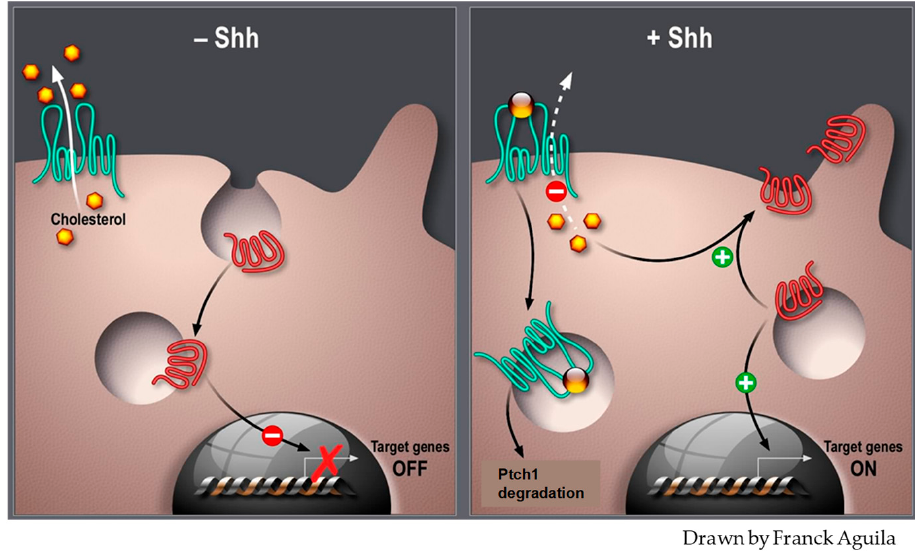
Figure 3. Ptch1 cholesterol transport activity regulates Hedgehog signaling. Ptch1 is represented in green, Smoothened in red, cholesterol in yellow, and Shh as a golden ball.